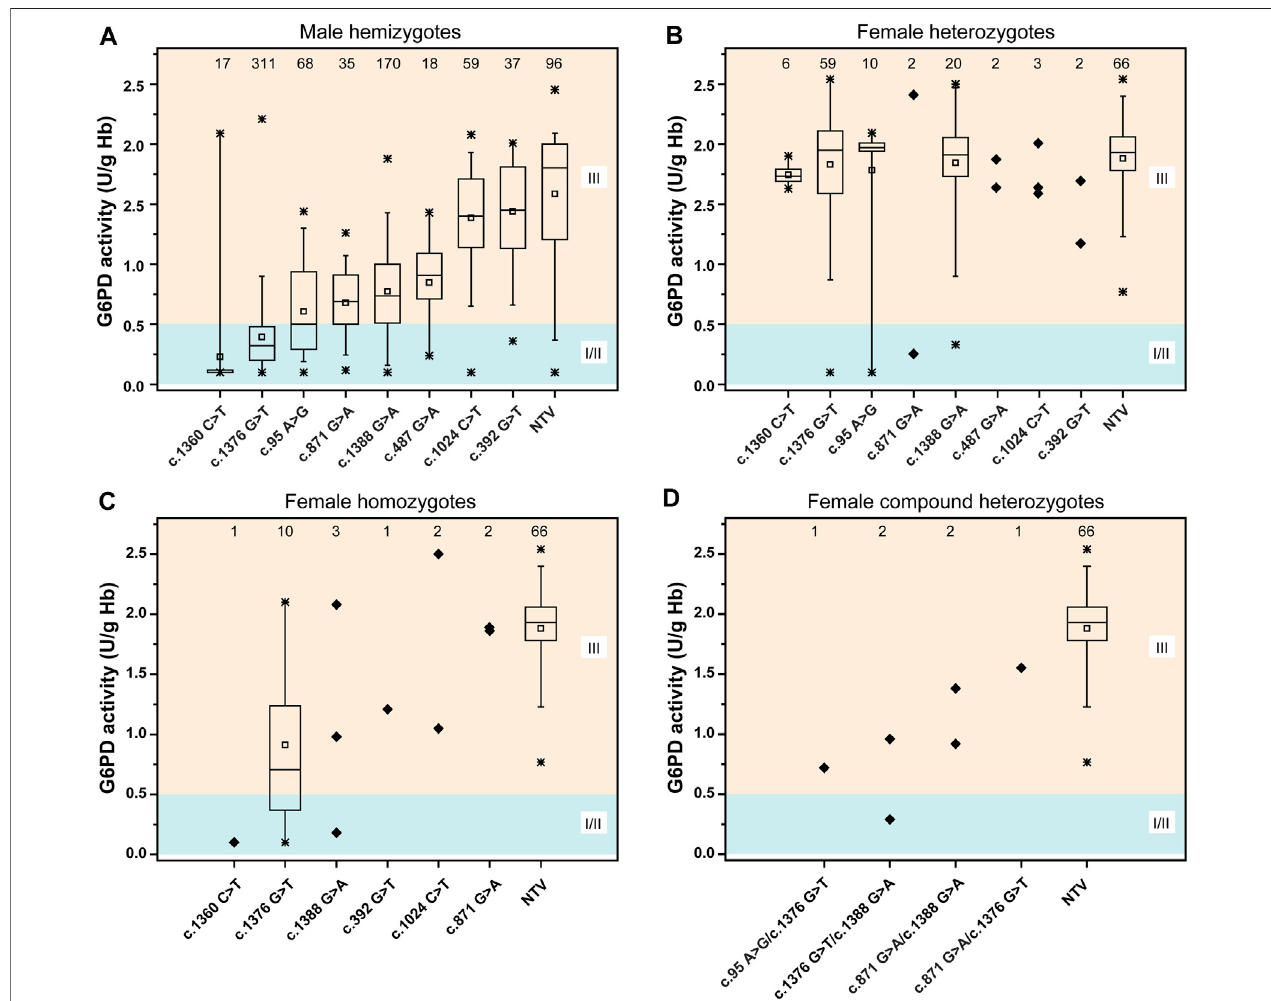
FIGURE 4 | Distribution of the G6PD activities of different variants. (A) G6PD activities for male hemizygotes. (B) G6PD activities for female heterozygotes. (C) G6PD activities for female homozygotes. (D) G6PD activities for female compound heterozygotes. According to WHO standard, the residual enzyme activity ≤ 0.5 U/g Hb (10% of normal) was grouped into class II (severe de fi ciency); the residual enzyme activity between 0.5 – 2.8 U/g Hb (10 – 60% of normal) was grouped into class III (moderate de fi ciency), the residual enzyme activity between 2.8 – 7.1 U/g Hb (60 – 150% of normal) was grouped into class IV (normal). Class I, which includes severelyde fi cientvariantsassociatedwithchronicnonspherocytichemolyticanemia(CNSHA).Statisticalanalysis:thelinewithintheboxdenotesthemedian,thesquare within the box denotes the mean, the horizontal borders of each box denote the 25th and 75th percentiles, the whiskers denote the 5th and 95th percentiles, and the stars denote the maximum and minimum. The samples were denoted as diagonal squares when statistical analysis cannot be performed due to the small sample size. NTV, negative for target variants.